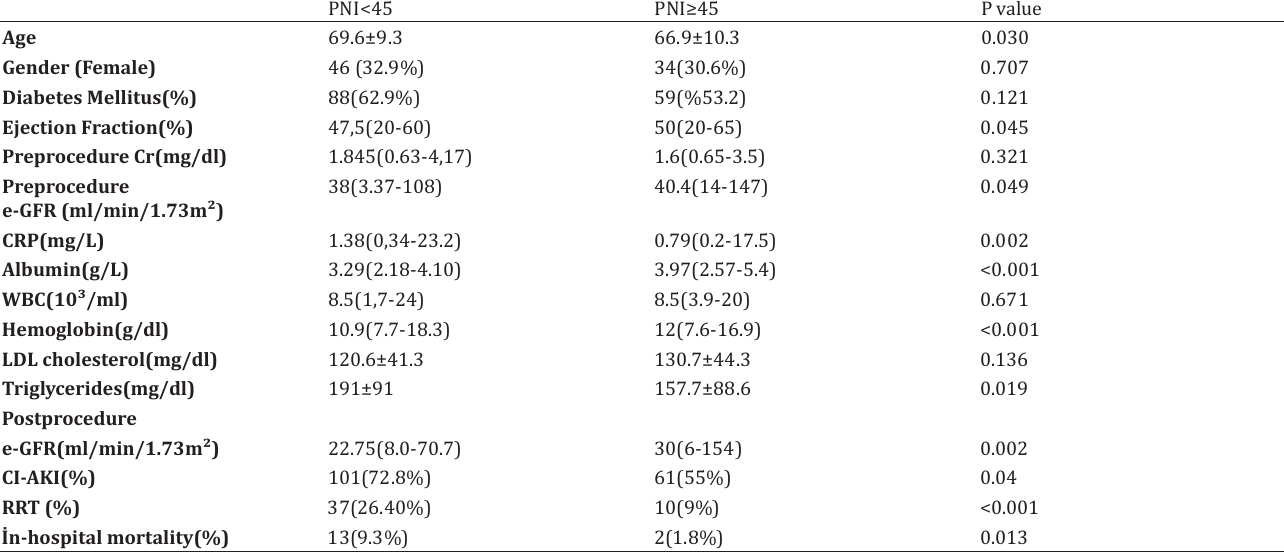
Demographic, clinical and biological characteristics of the patients according to their PNI score